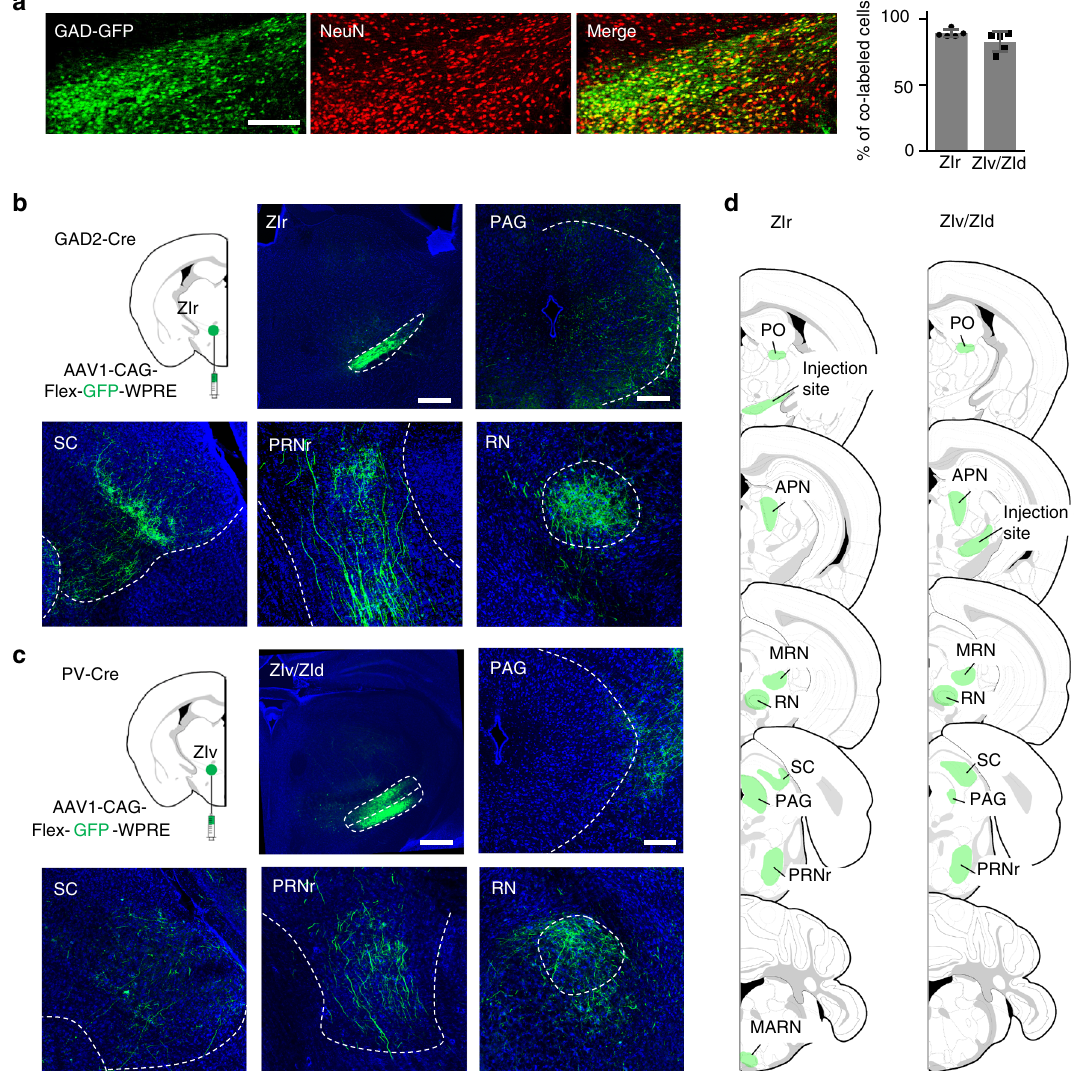
Fig. 1 A distinct GABAergic projection from ZIr to PAG. a Left three panels, co-localization of GFP (green) signal and NeuN (red) staining in the ZIr of a GAD67-GFP mouse. Scale: 200 µ m. Right panel, percentage of GFP + neurons in the rostral sector (ZIr) and more caudal part (ZIv/ZId) of ZI. b Injection of Cre-dependent GFP virus into ZIr of GAD2-Cre mice. Confocal images show GFP expression in the injection site (upper middle; scale: 500 µ m) and in several target structures (upper right and lower; scale: 200 µ m). Blue shows Nissl staining. ZIr zona incerta, rostral, PAG periaqueductal gray, SC superior colliculus, PRNr pontine reticular nucleus, rostral, RN red nucleus. c Injection of Cre-dependent GFP virus into ZIv/ZId of PV-Cre mice. Images show GFP expression in the injection site (upper middle; scale: 500 µ m) and in several target structures (upper right and lower; scale: 200 µ m). d Summary of target areas of GAD2 + ZIr (left panel) and PV + ZIv/ZId (right panel) neurons. PO posterior complex of the thalamus, APN anterior pretectal nucleus, MRN midbrain reticular nucleus, MARN magnocellular reticular